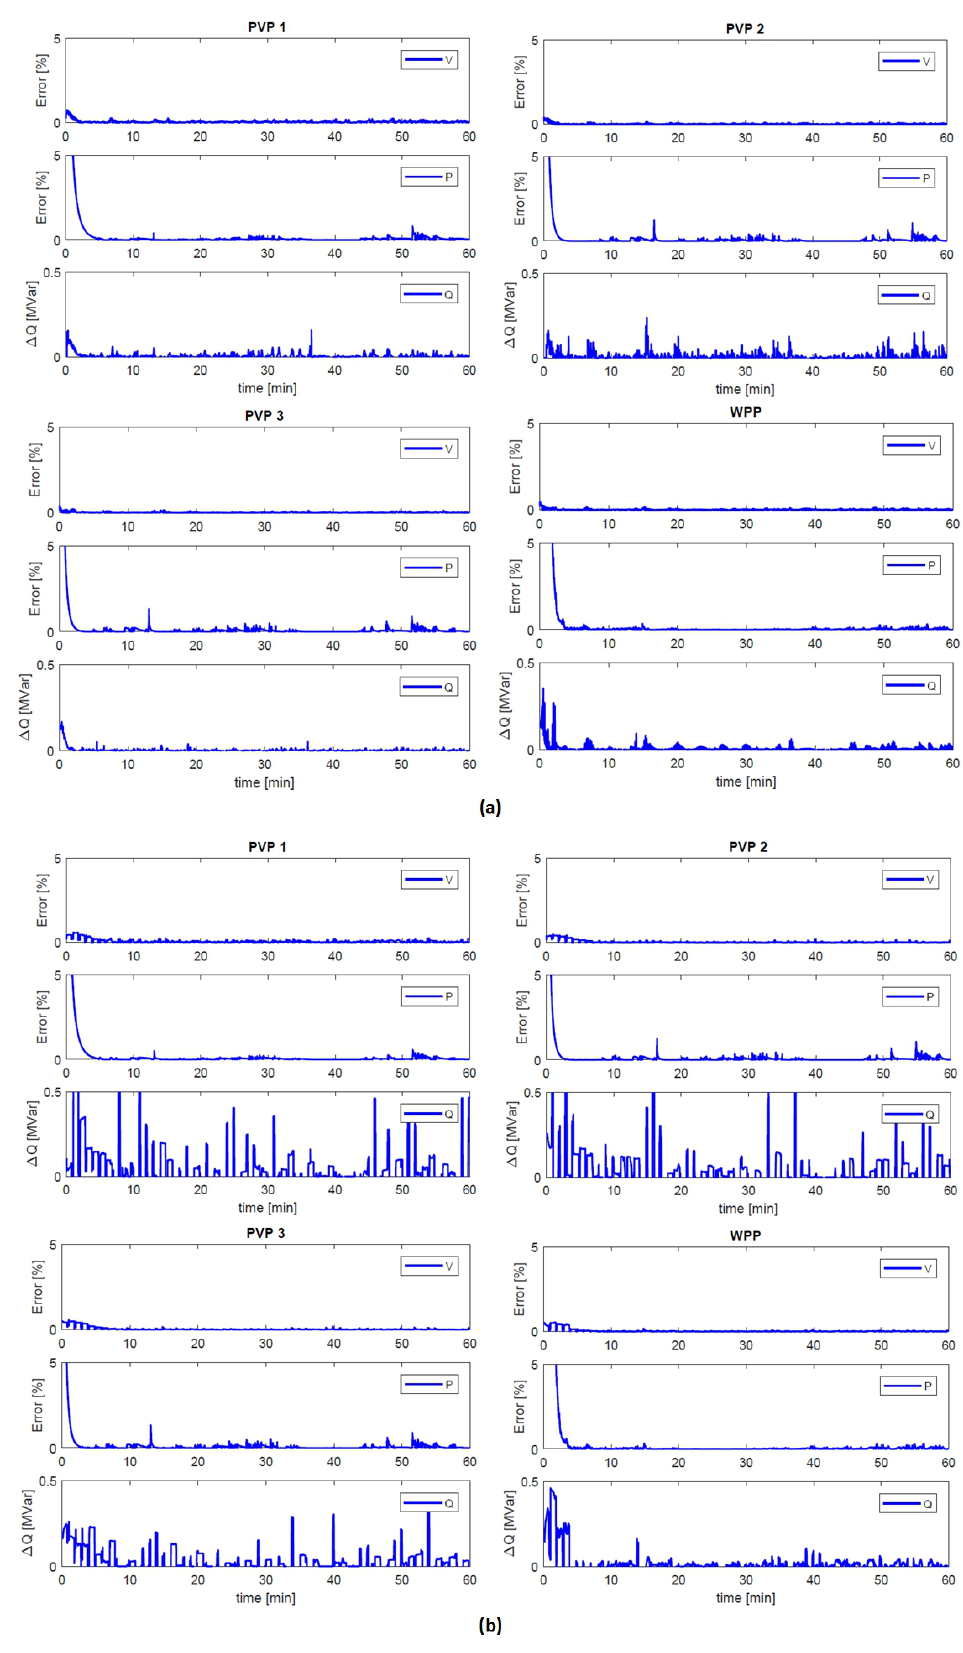
Figure 15. Error in V , P and Q of PVP 1, PVP 2, PVP 3 and WPP sent via non-RT and RT communication models over one hour with: ( a ) 10 s update rate; and ( b ) 1 min update